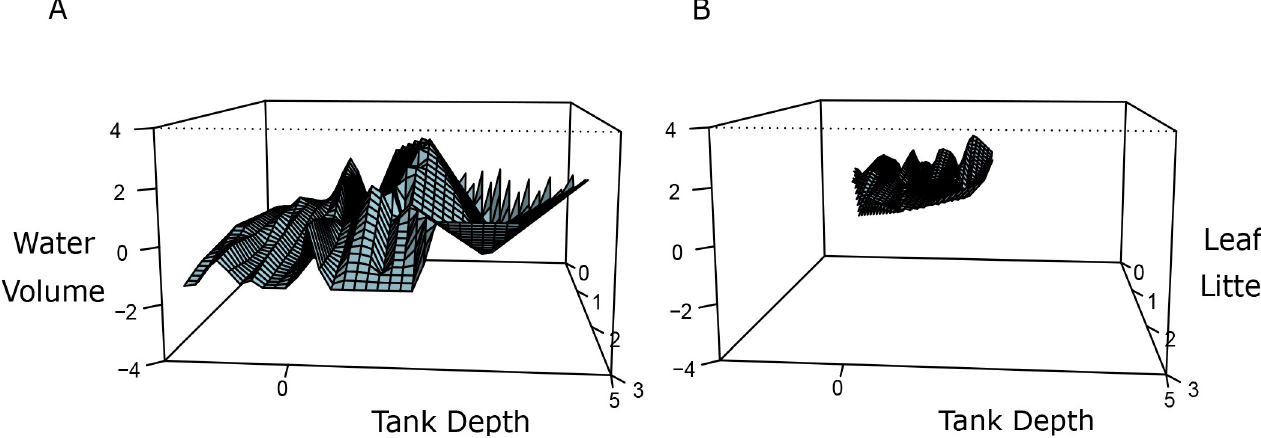
Fig 1. Trait space showing differences between data on bromeliads not occupied by a male of Aparasphenodon arapapa (NOBM) and occupied ones (OBM). (a) Unoccupied bromeliads in three-dimensional trait space, where the dimensions are bromeliad tank depth, water volume, and leaf litter. (b) Occupied bromeliads in the same three-dimensional trait